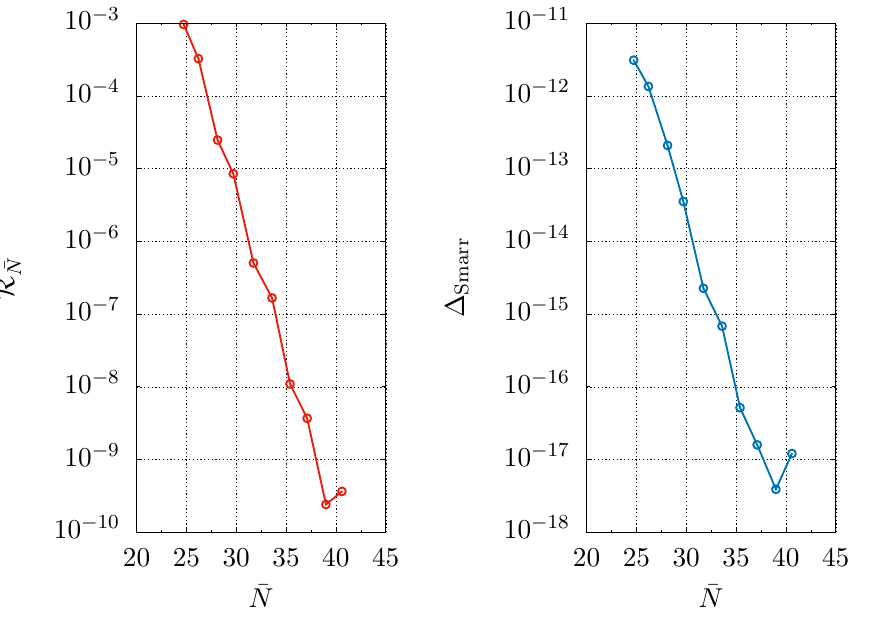
Figure 6 . Convergence of the numerical solutions for a localized black hole with inter polar distance L A =L 0 : 00703. For di(cid:11)erent resolutions (cid:22) N we show the maximal di(cid:11)erence (cid:25) reference solution with high resolution (left) and the deviation from Smarr’s relation (cid:1) Smarr = ( D 2) ~ T ~ S ( D 3 n ) ~ M (right). The mean resolution (cid:22) N is averaged over all domains and j (cid:0) (cid:0) (cid:0) (cid:0) j